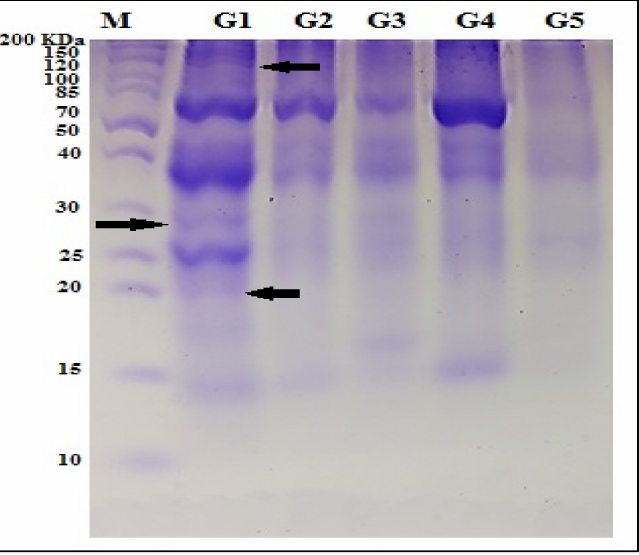
Figure 1. Protein SDS-PAGE profile for the studied Quinoa genotypes, G1: M-28; G2: Q-37; G3: S-10; G4: Regeolone-3; G5: LINE-6; arrows: unique bands for M-28